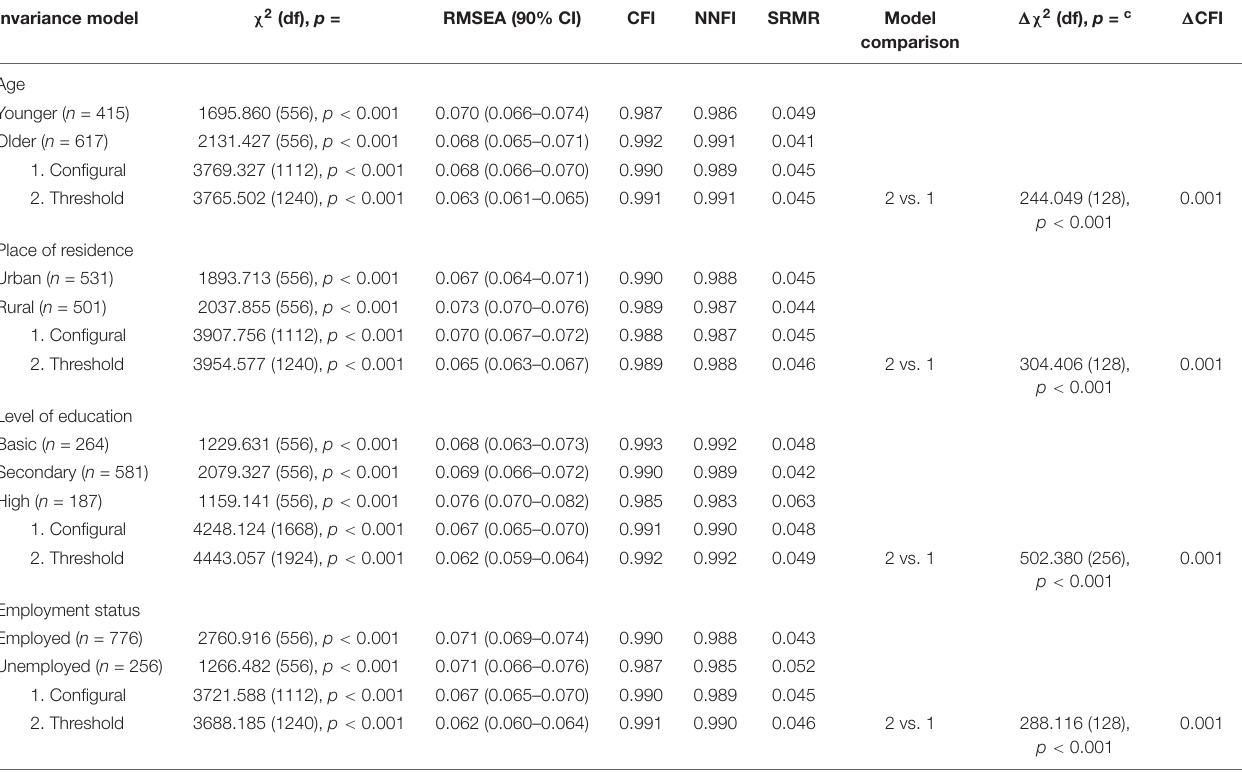
TABLE 4 | Measurement invariance model fitting indices and